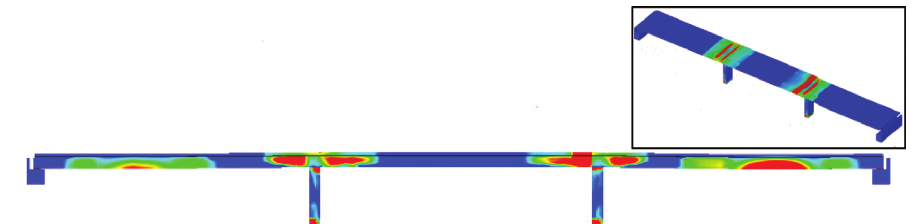
Figure 20: Principal normal strain of model “A2-M-K.”